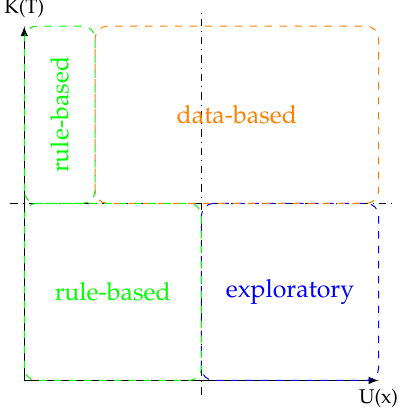
Figure 4. The figure highlights those areas in which the system operates with respect to the knowledge K ( T ) and satisfaction score U ( x ) . The lower parts present the general low information state, any change here depends on the satisfaction and reaction of the user. The upper part represents a high information state. As long as the reaction of the user is not categorically opposed to the interaction, the system prefers to remain with the adapted data-based behaviour; only in a breakdown does the system revert to the rule-based approach. In the case of a new situation and user interaction, the system transits to a satisfied exploratory stage to improve its information